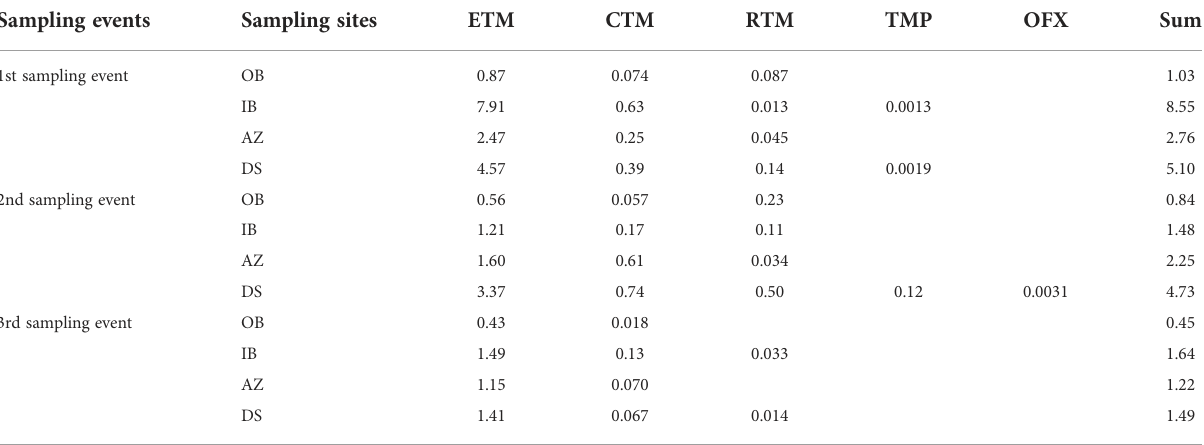
TABLE 2 The risk quotients of target antibiotics and the total risk quotients of samling sites in this study.